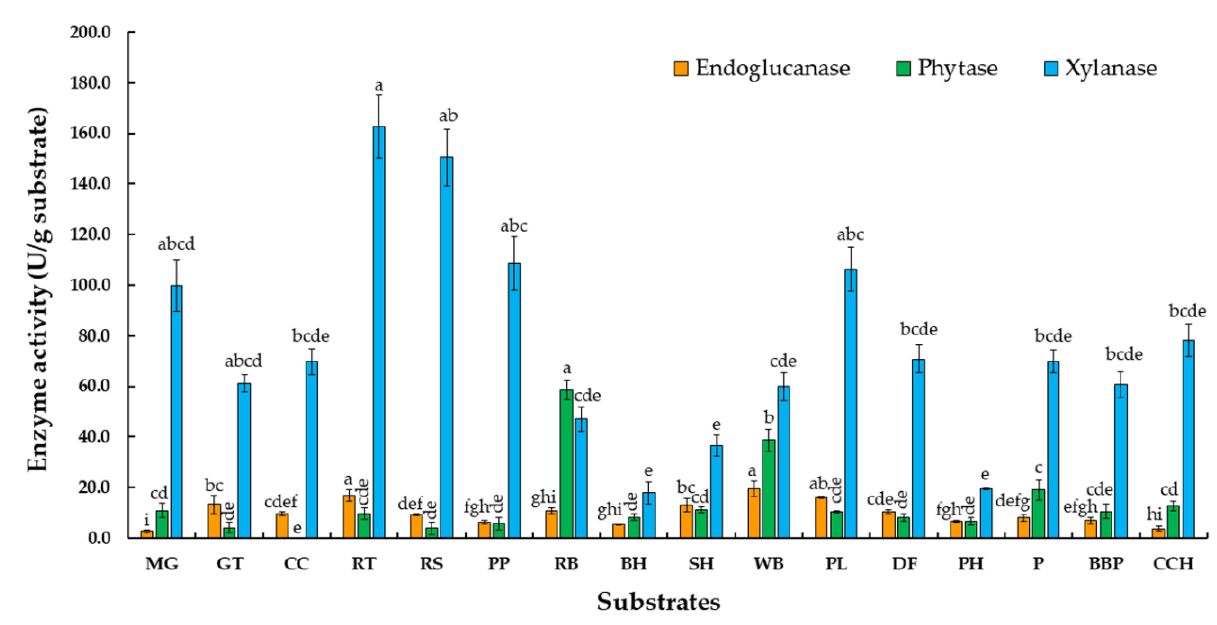
Figure 1. Effect of agricultural waste on phytase, endoglucanase, and xylanase production from various substrates (mango peel (MG), green tea leaf (GT), corncob (CC), red tea leaf (RT), rice straw (RS), pineapple peel (PP), rice bran (RB), bamboo husk (BH), soybean husk (SH), wheat bran (WB), pineapple leaf (PL), dragon fruit peel (DF), peanut husk (PH), palm residue (P), bamboo pulp (BBP), and coffee cherry peel (CCH)) by Thermoascus aurantiacus SL16W under semi-solid state fermentation after being incubated at 45 °C for 7 days. Average ± standard deviation from three replicate experiments. Different letters in the same column are considered significantly different according to Duncan’s multiple comparison test ( p ˂ 0.05).